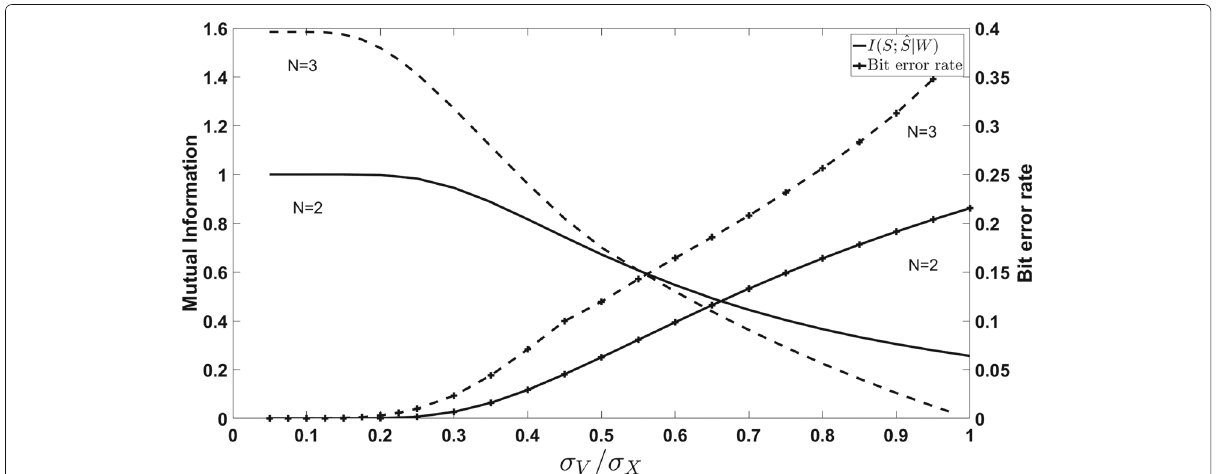
Fig. 6 Comparison of ZLHDS with N = 2 versus N = 3. Lines without markers: Mutual information between the enrolled key S and the reconstructed key ˆ S given helper data W , as a function of σ V /σ X . Markers: bit error rate as a function of σ V /σ X . The curves follow equations (22) and (26) from